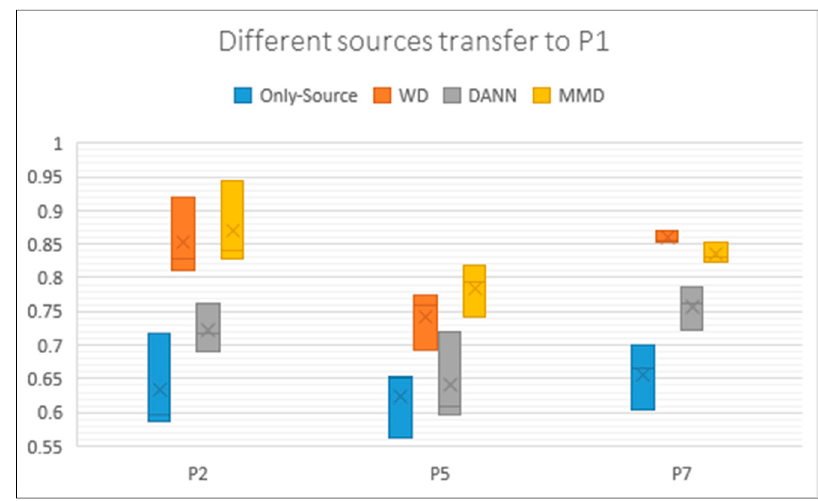
Figure 7. Box plot of the accuracy of P2, P5, and P7 transfer to P1. Each Box feeds back the results of three experiments. It can be seen that some box lines are long and show obvious fluctuations. The y axis represents the accuracy rate of these experiments. The same with the following tables.